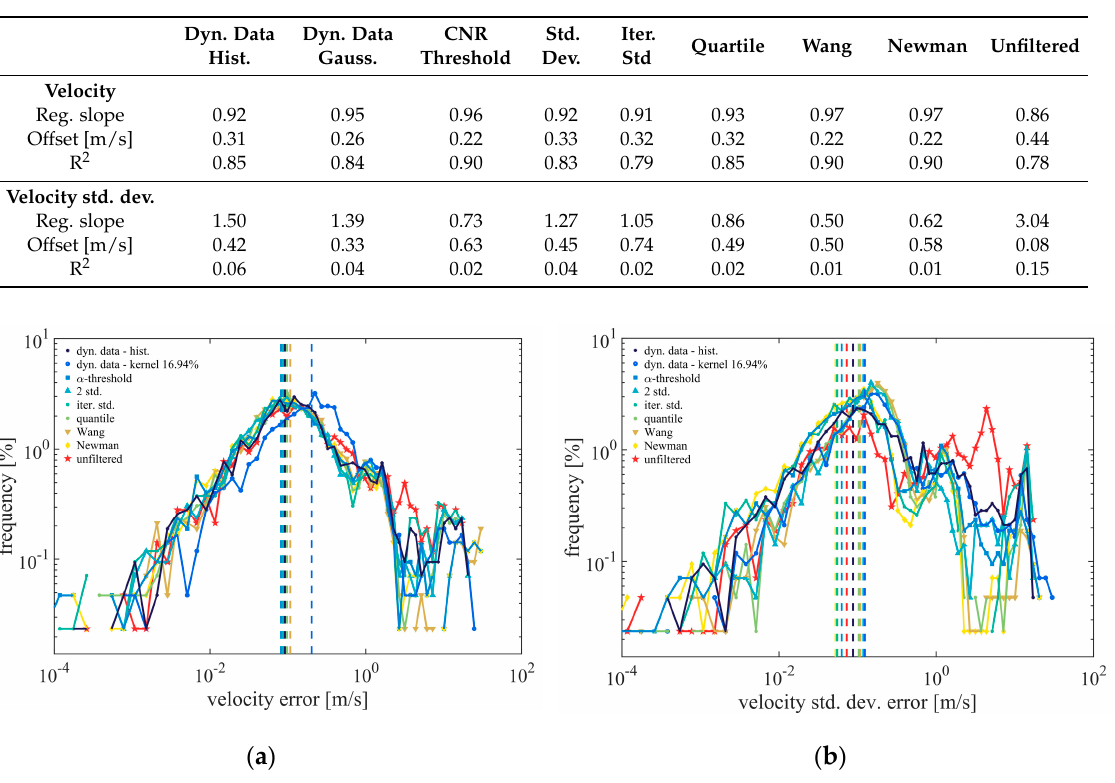
Table 2. Correlations and residuals of the linear regression between the ultrasonic anemometer and the LiDAR for the velocity and the standard deviation of the velocity. From 21.12.2013 15:35 h (UTC) till 19.01.2014 7:55 h (UTC) for all wind directions. Dyn. Data Hist.